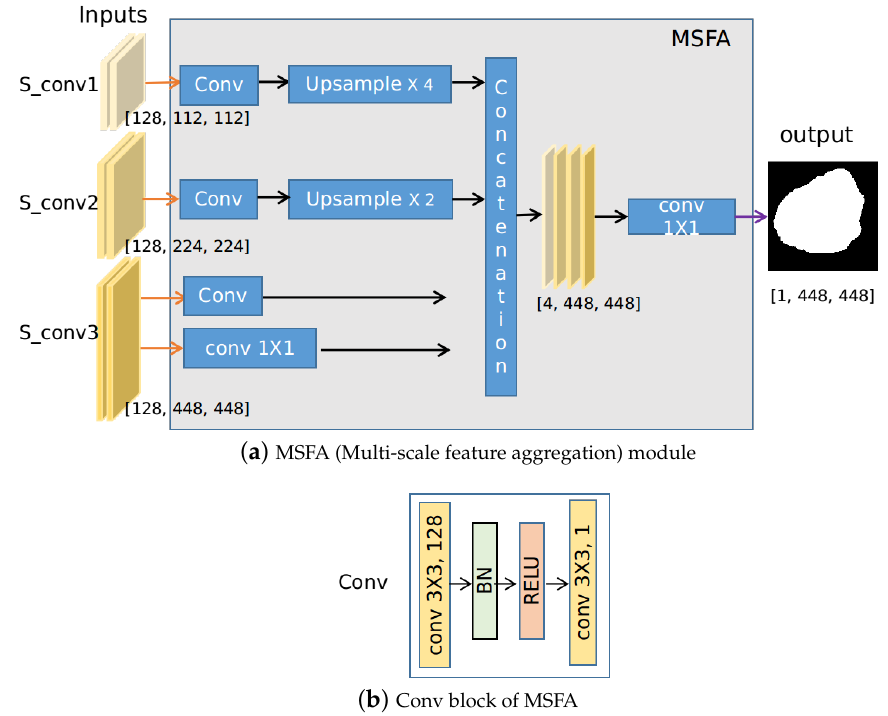
Figure 4. Implementations of the MSFA module, where the segmentation branch is used as an example. The inputs are feature maps of different scales from the segmentation branch, e.g., S conv 1 , S conv 2 , S conv 3 . Four prediction masks are obtained after some convolution and pooling operation. The final output is the weighted sum of these predictions which can be automatically learned by 1 × 1